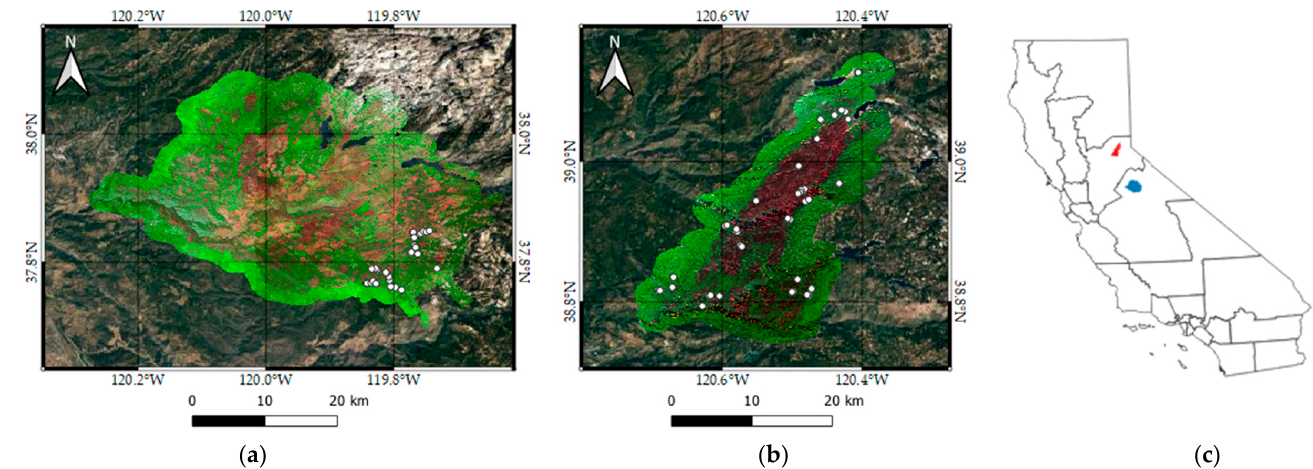
Figure 1. Infrared colour composites of the study areas, in which Red: MASTER band 21 (centred at 2.16 µ m), Green: MASTER band 9 (centred at 0.87 µ m), and Blue: MASTER band 5 (centred at 0.66 µ m). ( a ) Shows the extent of the Rimfire; ( b ) Shows the extent of the King fire; ( c ) Shows an overview map of California USA, visualizing the Rim fire (blue) and the King fire (red). In both ( a , b ), the white circles represent the field sampling locations. Background images display Google Earth imagery.